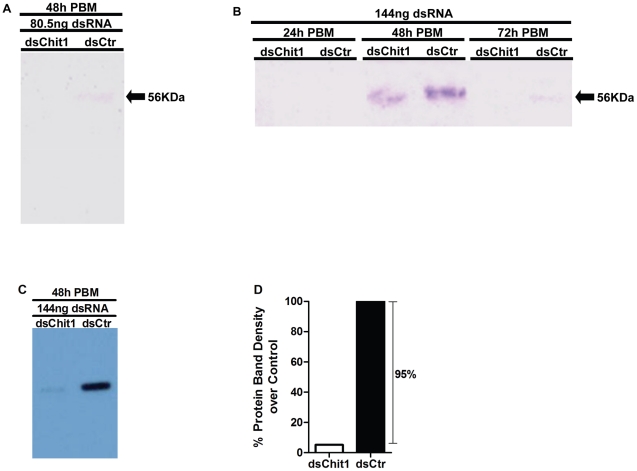
dsRNA effect on PpChit1 protein levels.(A). Western blot assay pointing to PpChit1 knock down in dsPpChit1 injected flies (80.5 ng dsRNA) at 48 h PBM. (B). Midgut extracts from flies injected with 144 ng dsPpChit1 (dsChit1) displayed weaker bands (56 kDa) than dsControl (dsCtr) injected flies at 48 h and 72 h PBM. A–B, Colorimetric development. (C). Western blot assay depicting strong PpChit1 expression reduction in flies injected with 144 ng dsPpChit1 (dsChit1) compared with dsCtr injected ones at 48 h PBM (Chemiluminescence development). (D). Densitometry analysis of PpChit1 protein bands obtained in the chemiluminescence assay revealing 95% reduction in PpChit1 expression between dsPpChit1 and dsControl injected flies.